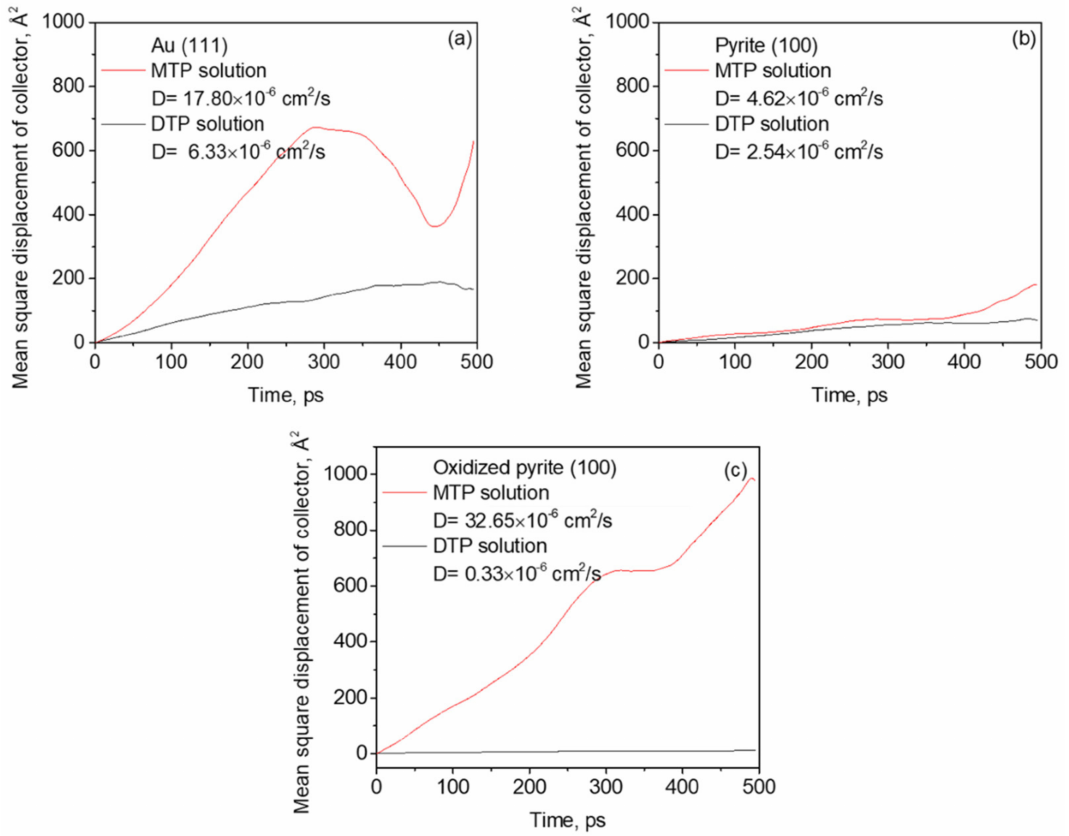
Figure 6. Mean square displacement of DTP/MTP on Au (111) ( a ), pyrite (100) ( b ), oxidized pyrite (100) ( c )